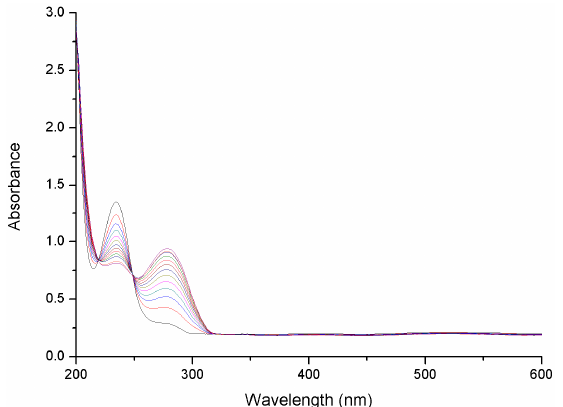
Figure 1. UV ‐ visible spectra recorded during the homocoupling reaction of 150 μ M 1 in aqueous pH 8 borate buffer (10 mM) and catalyst Pd ‐ PPy ‐ PS (1.8 μ M, 1.2 mol ∙ % Pd) over the course of 24 h at 70 °C.